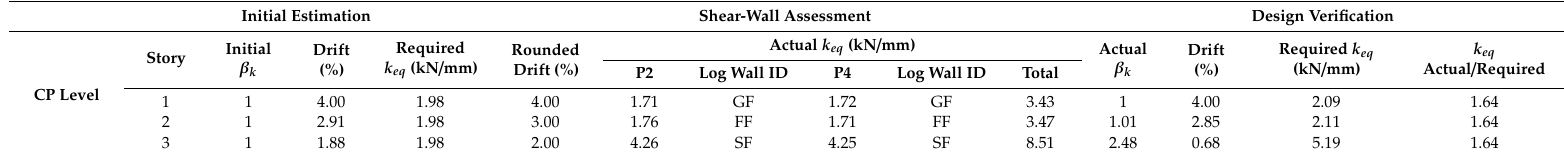
Table 7. CP level analysis (Y-direction), accounting for the EP shear-wall sti ff